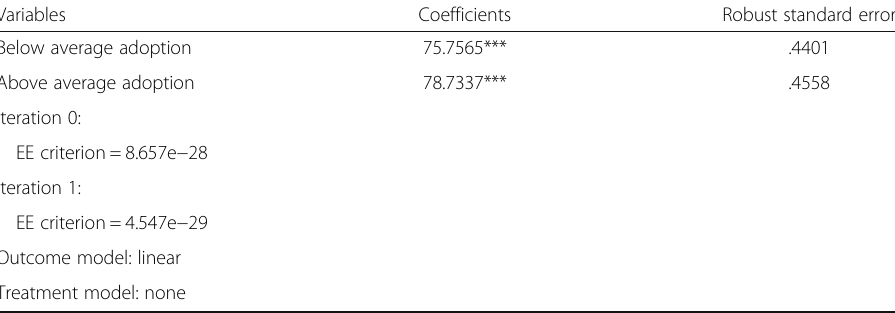
Table 7 Potential outcome means of farmers ( n = 300)